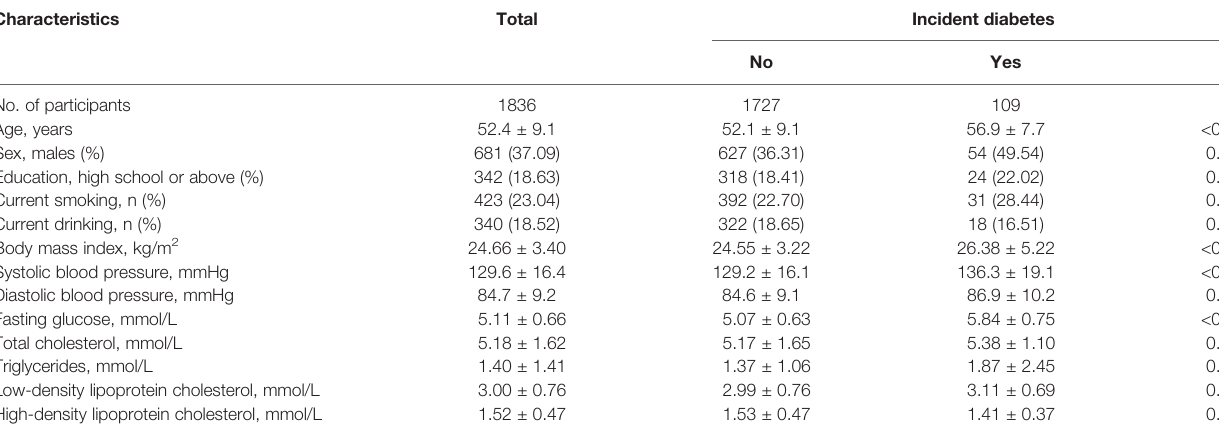
TABLE 1 | Baseline characteristics of study participants according to incident diabetes during follow-up.